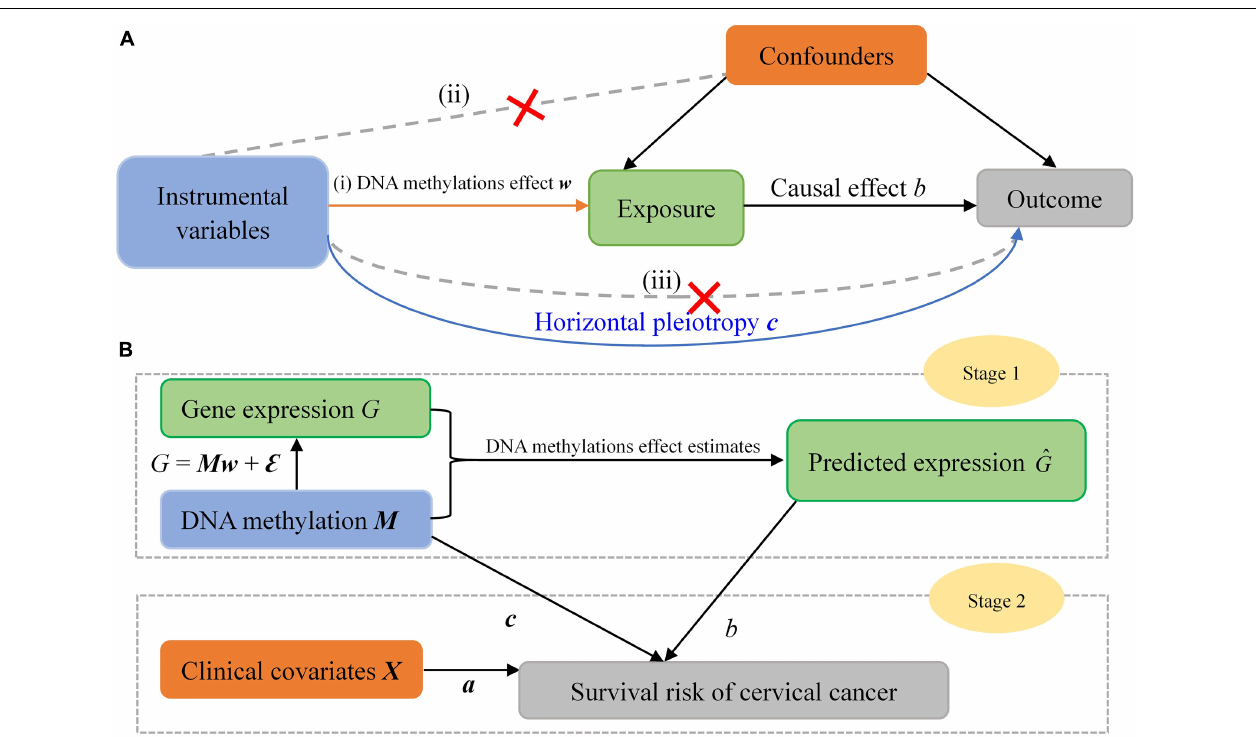
FIGURE 2 | (A) Mendelian randomization framework for the two-stage association analysis. The three assumptions for valid instrumental variables (IV) are indicated by arrows or the absence of arrows: (i) the relevance assumption: the IV is robustly associated with the exposure; (ii) the independence assumption: the IV is not associated with confounding factors; (iii) the exclusion restriction assumption: there is no alternative way that the IV affects the outcome other than via the exposure. The blue solid line represents direct effects of DNA methylations. (B) Statistical scheme of our two-stage inference